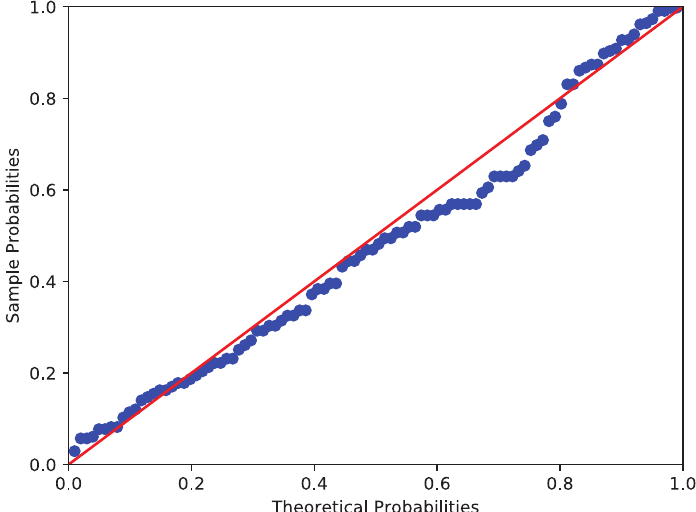
Figure 6. P-P plot of RBC count in female athletes (Red line and blue line respectively denote the theoretical probabilities and sample